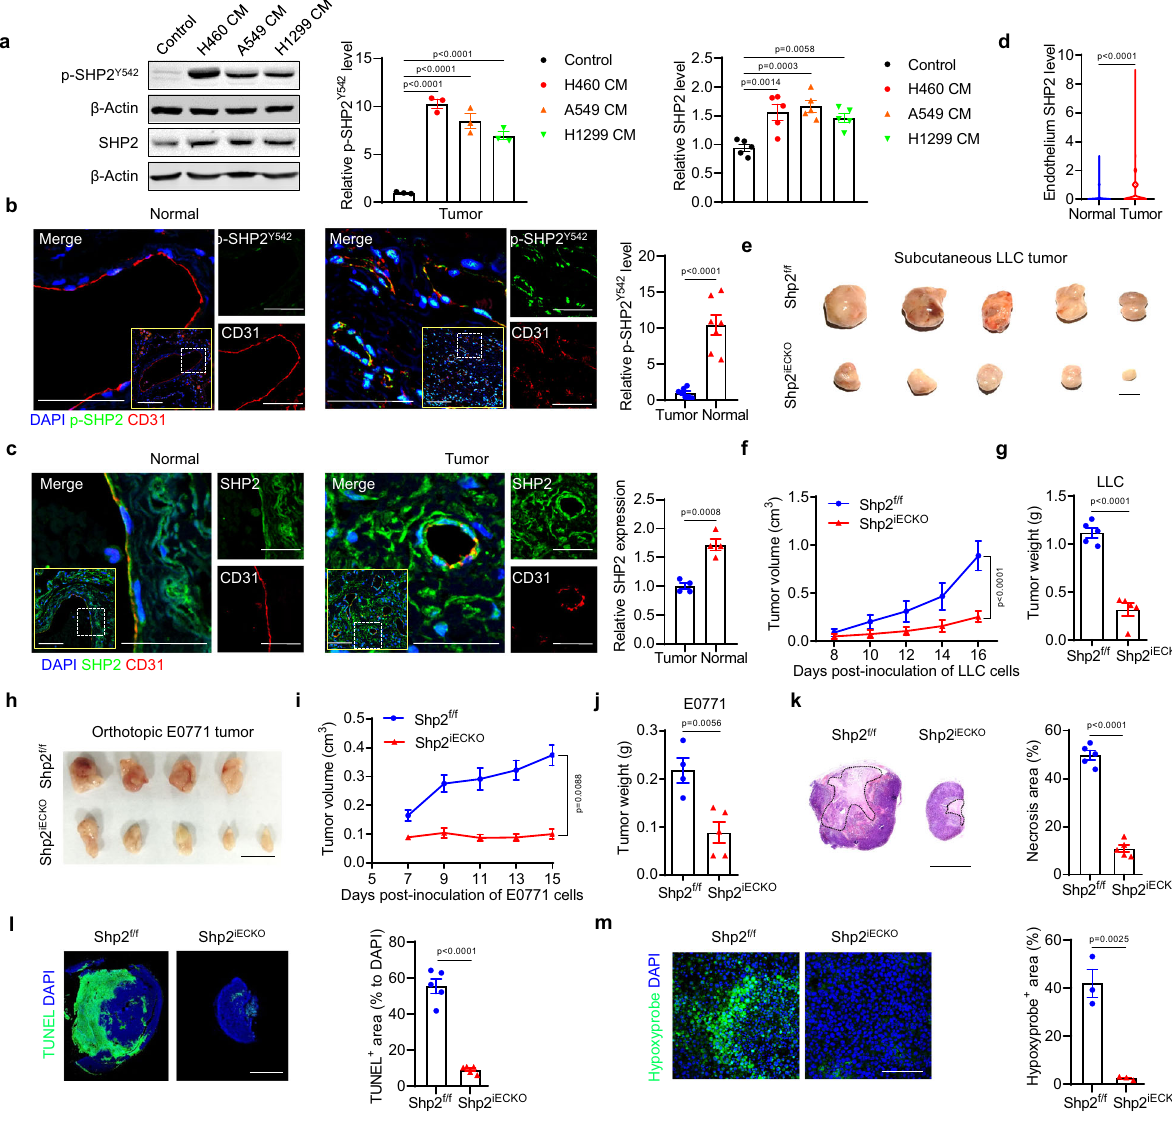
Fig. 1 Hyper-activated SHP2 in tumor endothelial cells is necessary for tumor growth. a Western blot for p-SHP2 Y542 and SHP2 in HUVECs treated with various NSCLC cancer cell-conditioned media for 10 min (p-SHP2, n = 3) or 24 h (SHP2, n = 5). β -Actin was used as a loading control. Quantitative data were shown as mean ± SEM. p -values were shown and generated by one-way ANOVA with multi-comparisons. b , c Representative images showing p-SHP2 Y542 ( b , green) and SHP2 expression ( c , green) in CD31 + vessels (red) in NSCLC tumor tissues and paired adjacent normal tissues ( n = 7 for p-SHP2 and n = 4 for SHP2). Quantitative data were shown as mean ± SEM. p -values were shown and generated by using the two- tailed Student ’ s t -test. Scale bar: 50 μ m; inset 100 μ m. d Shp2 mRNA expression in mouse normal and tumor endothelial cells was extracted from